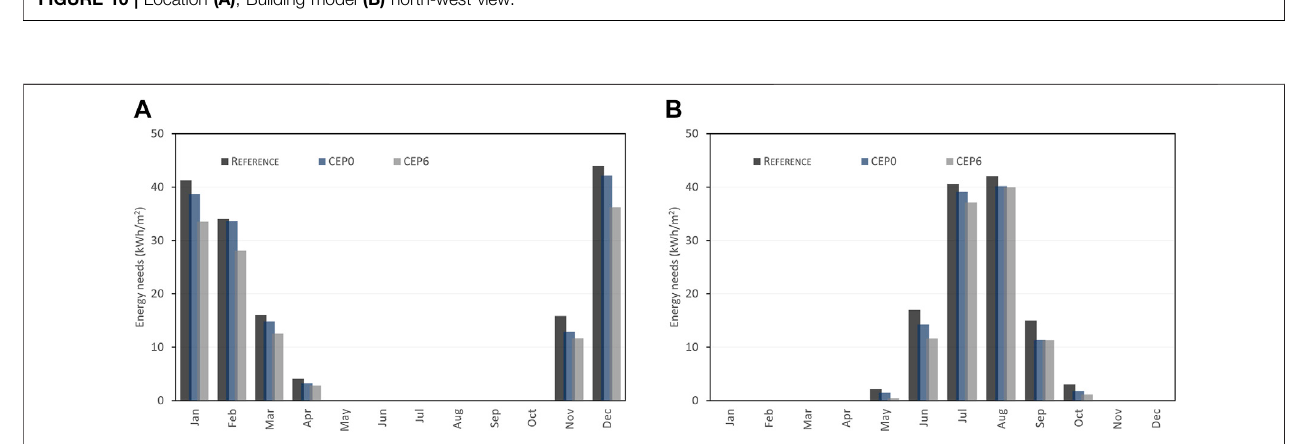
FIGURE 11 | Monthly energy needs for (A) heating (B)